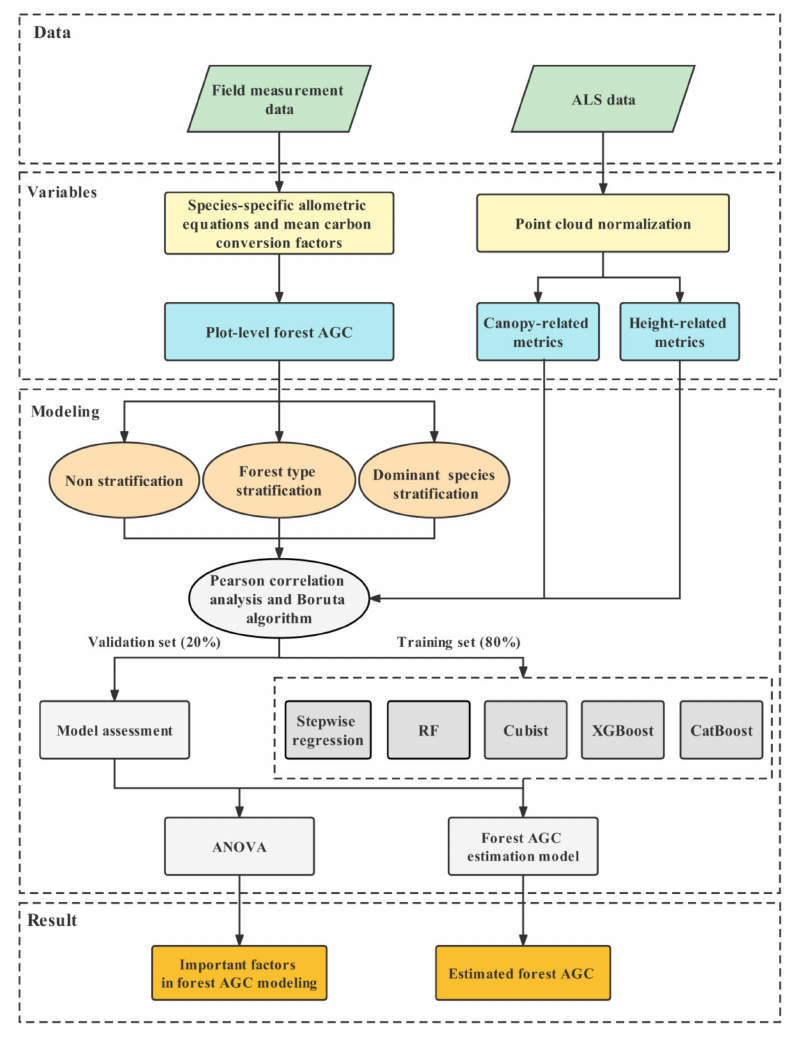
Figure 3. Flowchart of the methods for forest AGC estimation by combining sample plots stratification and ML algorithms using ALS